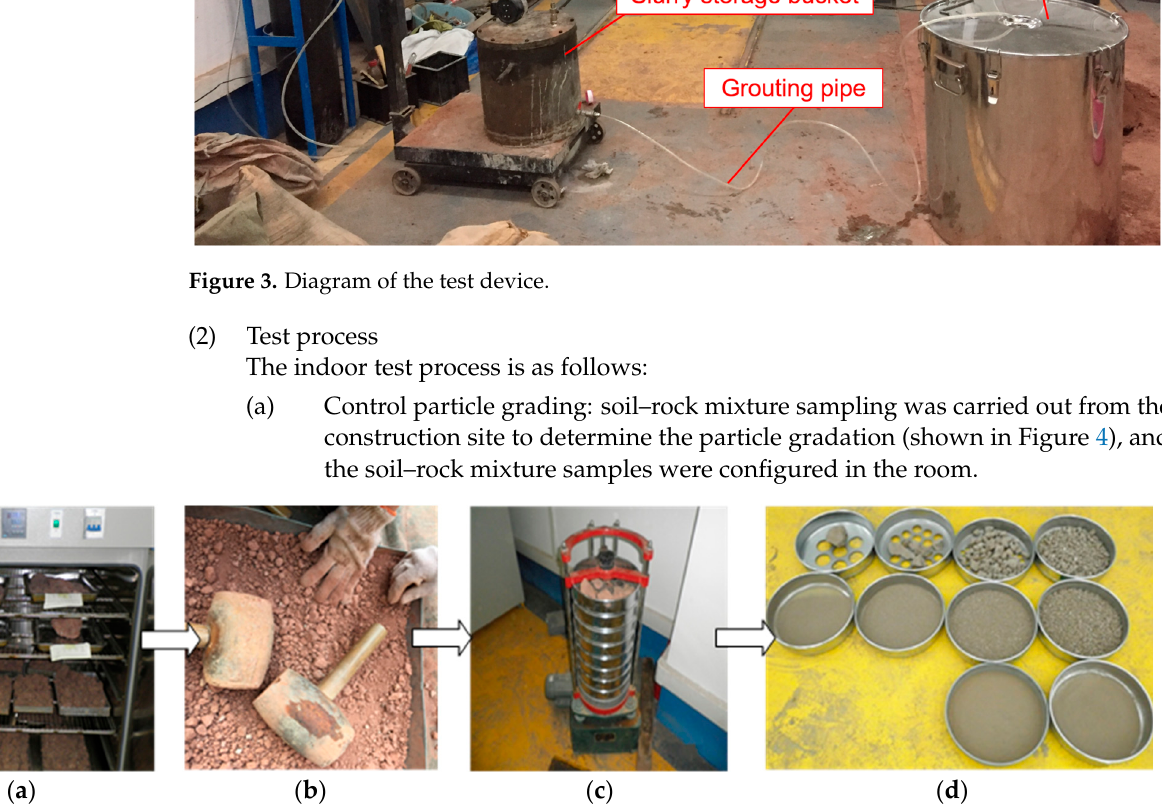
Figure 5. Control water content. (c)